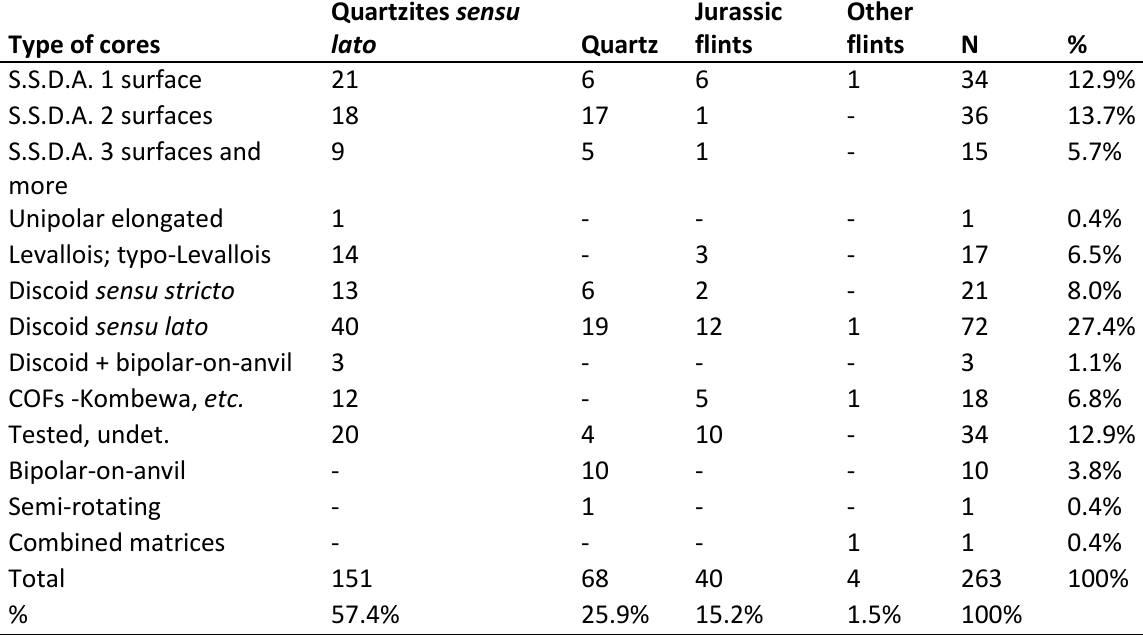
Table 9. Types of cores identified in the Camillo